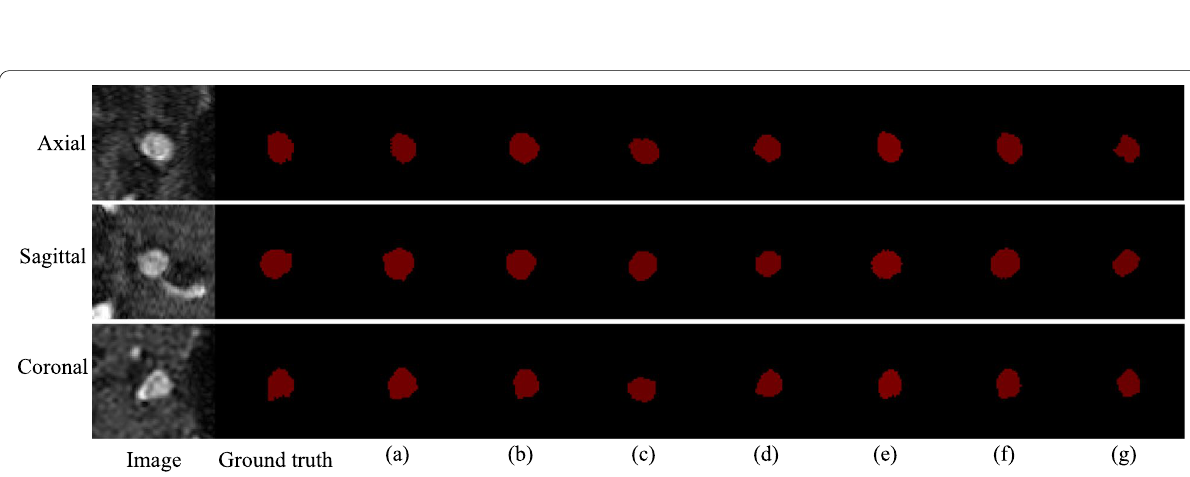
2D CNN; c HeadXNet; d DeepMedic; e GLIANet; f +